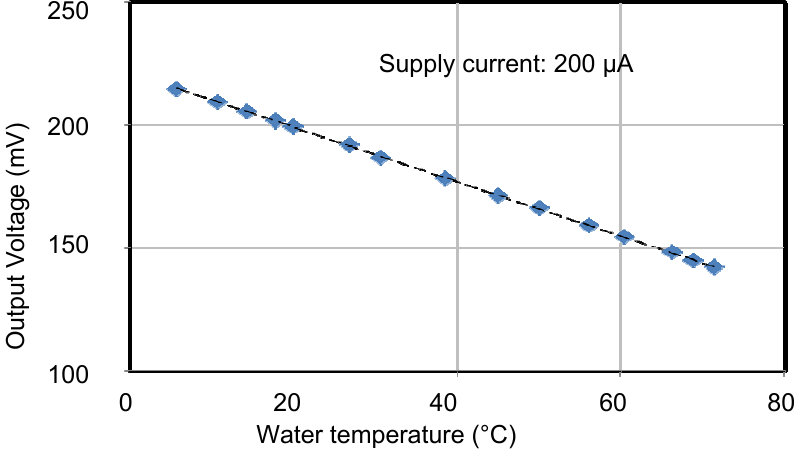
Figure 8. Characteristics of the temperature sensing area. It has a good sensitivity of 1.1 mV/°C and good